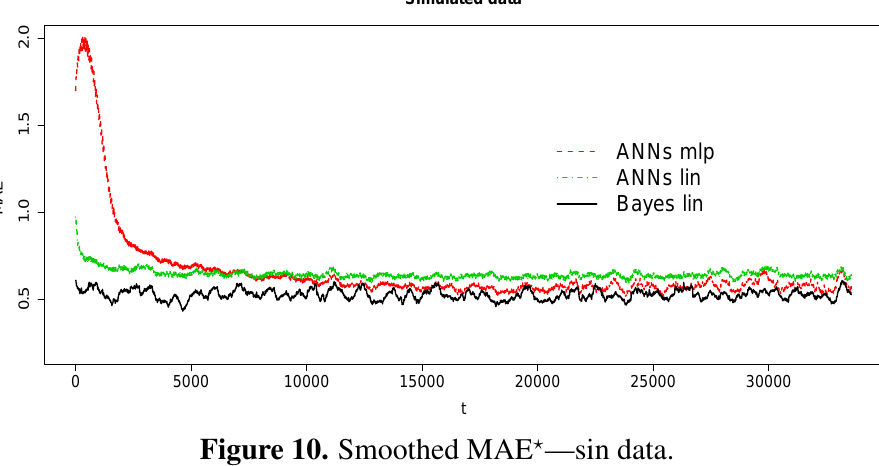
Figure 10. Smoothed MAE (cid:63) —sin data.